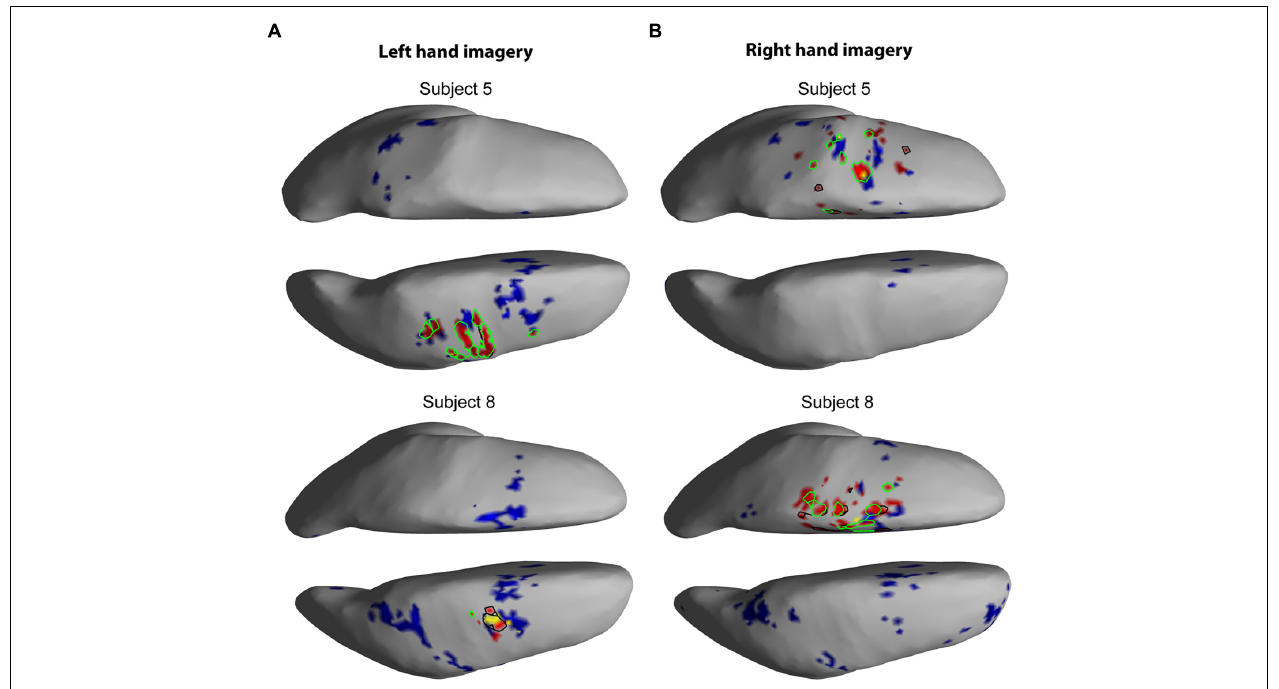
FIGURE 6 | EEG and fMRI BOLD activity mapped to realistic cortical headmodels of subjects 5 and 8. The cortical surfaces have been smoothed for better visibility. Blue indicates significant fMRI BOLD activity at Z -score > 2.3. Red indicates significant EEG HG activity at Z > 7, the black